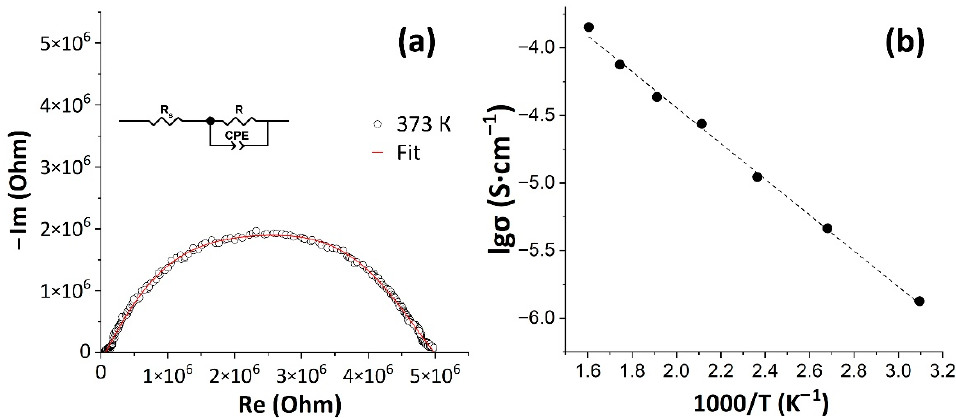
Figure 7. The impedance spectrum of a SnO 2 thick film at a measurement temperature of 373 K ( a ) and temperature dependence of its total electrical conductivity ( b ) (the black markers indicate experimental values, and the dashed line is the result of linear approximation).